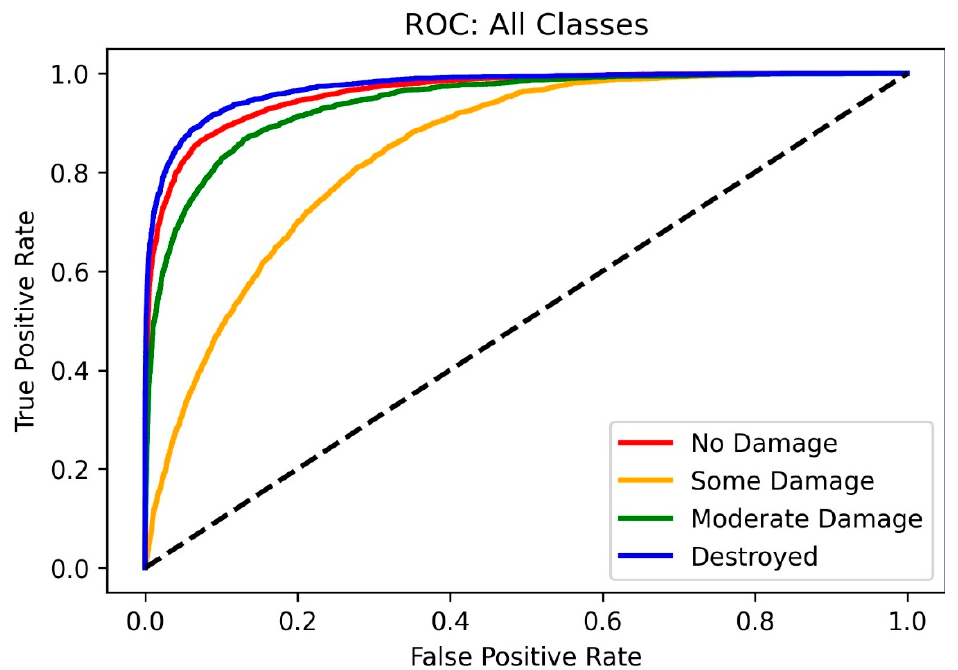
Figure 4. ROC curves for all four damage magnitude levels.